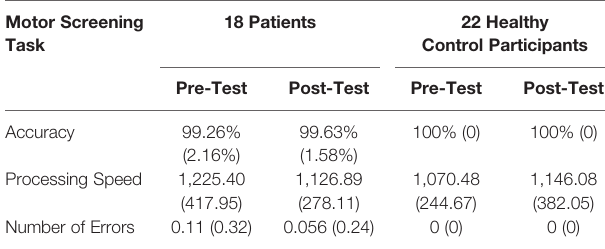
TABLE 2 | Means and standard deviations of accuracy, processing speed, and number of errors for motor screening task. Motor Screening